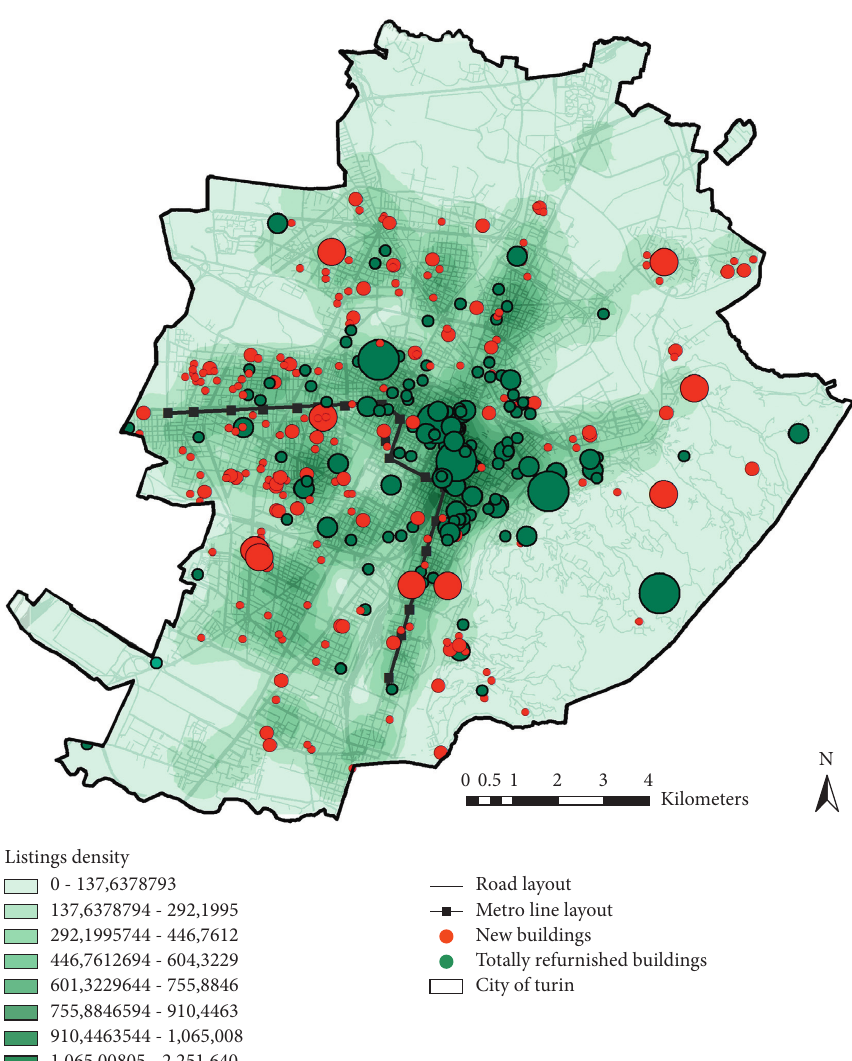
Figure 4: Housing construction sites in the city of Turin in the 2011–2018 time period divided in new buildings (CSDTYP1) and totally refurbishedbuildings (CSDTYP2).Thediameterofpoints isproportionalto thenumberofhousingunitsof eachsite